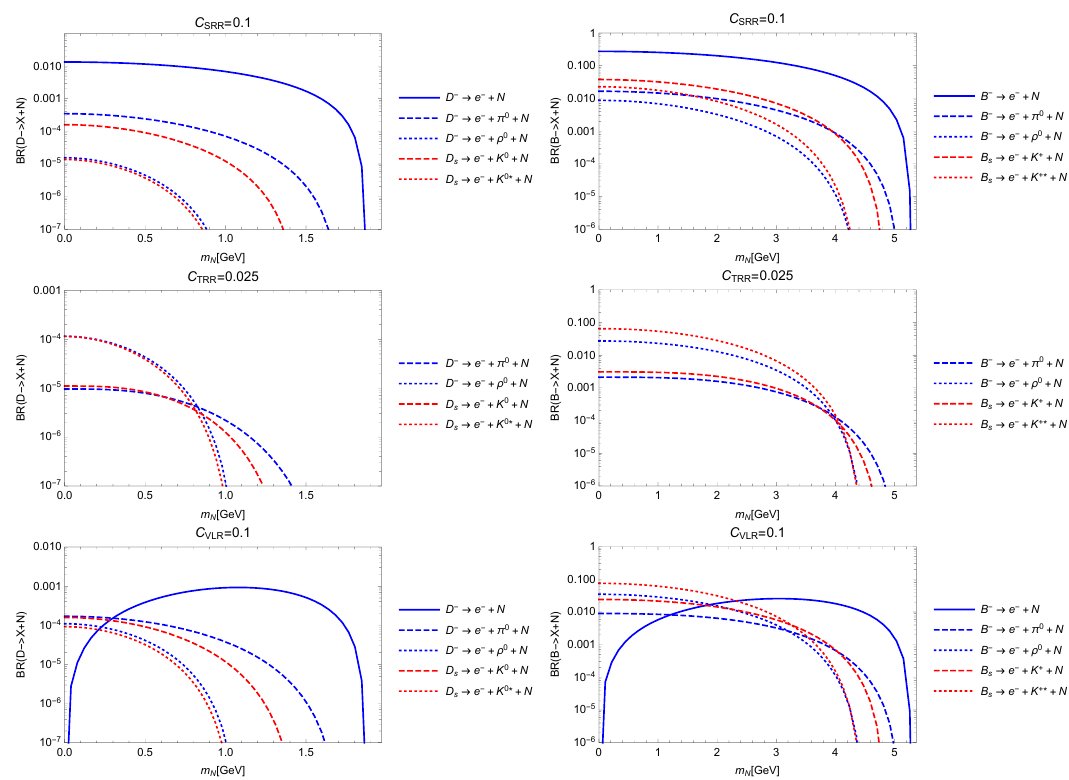
Figure 2 . Branching ratios of D and B mesons in the left and right panels, respectively. Left: from top to bottom the (cid:12)gures correspond to ( C (6) ) 21 e 4 = 0 : 1, ( C (6) ) 21 e 4 = 0 : 025 SRR TRR and ( C (6) ) 21 e 4 = 0 : 1, respectively. Right: from top to bottom the (cid:12)gures correspond to VLR ( C (6) ) 13 e 4 = 0 : 1, ( C (6) ) 13 e 4 = 0 : 025 and ( C (6) ) 13 e 4 = 0 : 1, SRR TRR VLR